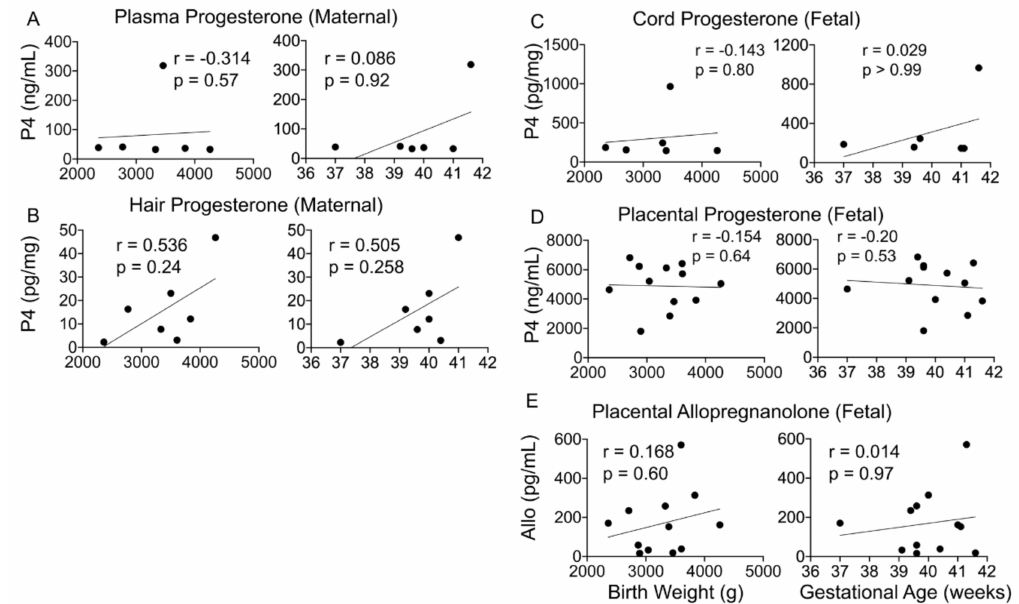
Figure 4. Maternal–fetal progesterone and its metabolites and correlation with birth outcomes. ( A – E ) Maternal and fetal progesterone ( n = 6) or placental ALLO ( n = 17) levels did not significantly correlate with infant birth weight or gestational age. Spearman’s correlation